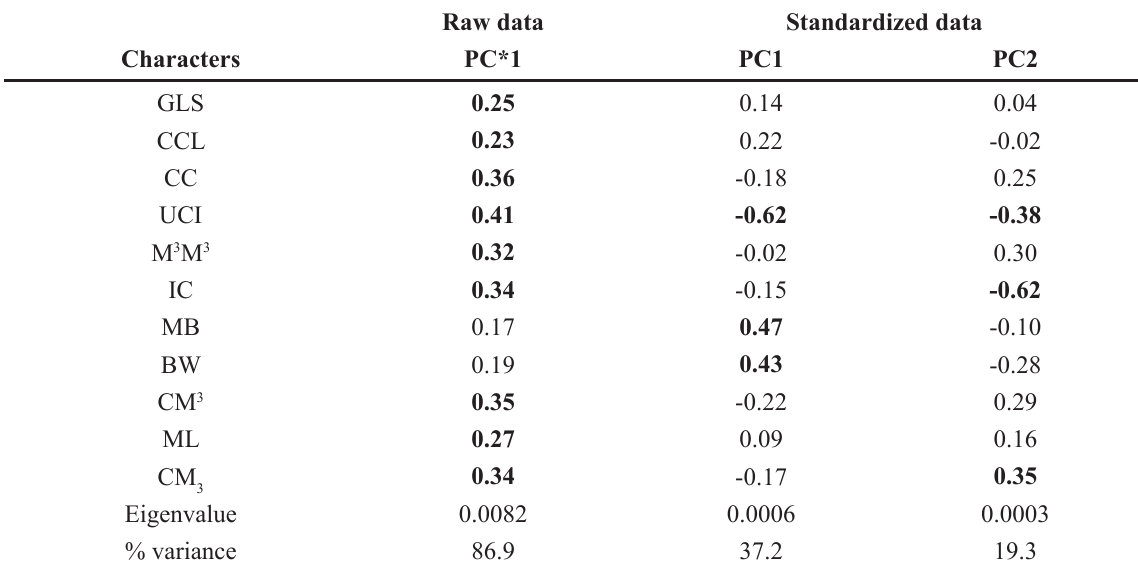
Table 3. Factor loadings of craniodental characters for the PCs obtained from principle component analyses (PCAs) of specimens of Tylonycteris . Acronyms and definitions for measurements are given in Material and methods. The first PCA is based on raw data (PC*1), while the second PCA is based on the log-transformed, standardized data (PC1 and PC2). Values in bold indicate the most significant